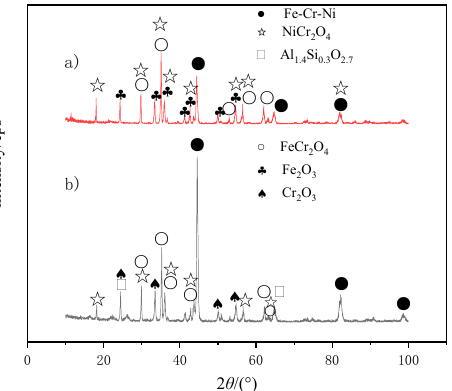
Figure 5. XRD spectra of sample uncoated and coated with nine-layer mullite film after cyclic oxidation at 900 ◦ C for 100 h: ( a ) uncoated sample; ( b ) coated nine-layer mullite film sample. Figure 6 shows the cross section morphology of the samples uncoated and coated with different-layer films after oxidation. The oxides scale formed on the uncoated sample were thicker and had a lamellar structure. Many cracks were present. A few internal oxides were formed for the sample with a single layer, indicating its poor protection. A continuous thin oxide scale layer was formed on the samples with three-layer and six-layer film, whose thickness was very close. A relatively thicker oxides scale layer was formed for the sample with nine-layer, which means that the complex scale phases were present. It is consistent with the XRD results.